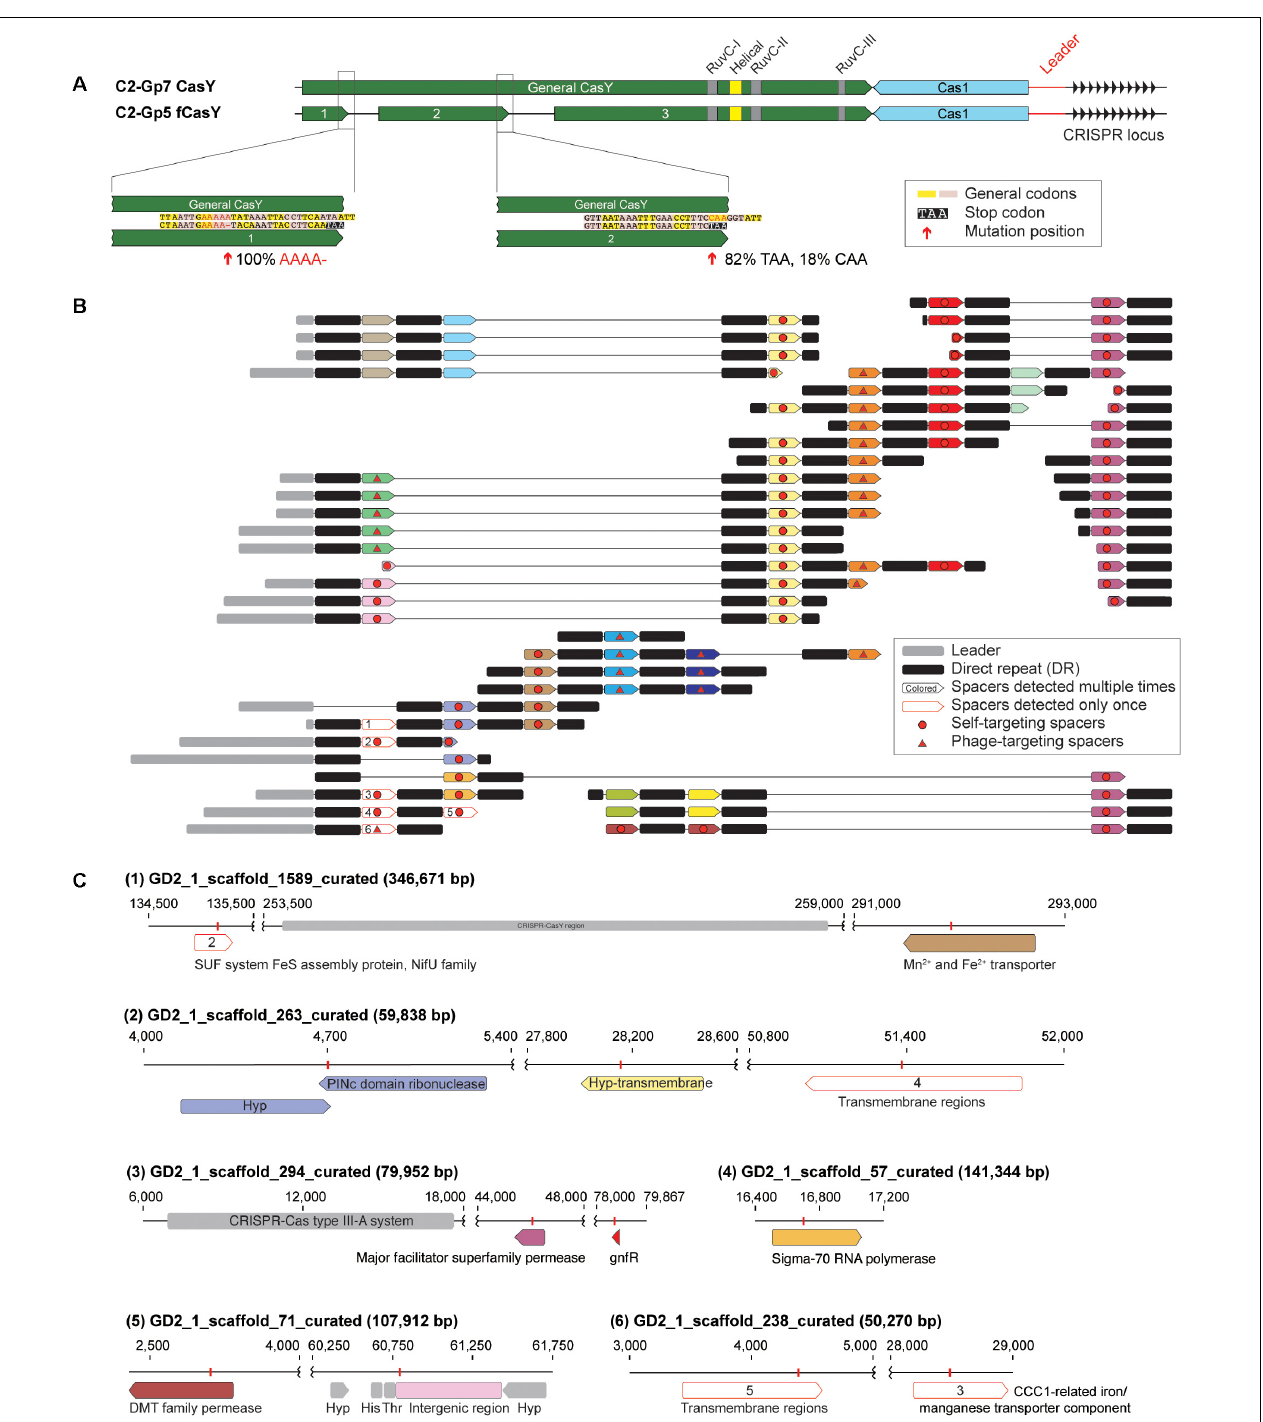
FIGURE 5 | One Roizmanbacteria genome encodes and unusual CRISPR system with a fragmented CasY (fCasY) protein and self-targeting spacers. (A) Mutations leading to fragmentation of CasY proteins into three pieces (red arrows) and their incidence in the population, and other features of the locus. (B) The reconstructed CRISPR locus showing the history of spacer acquisition and the distribution of self-targeted spacers (marked by red circles). (C) Scaffolds encoding genes and an intergenic region matching the self-targeting spacers. The targeted genes have the same color as the corresponding spacers in (B) , genes targeted by single copy spacers [white in (B) ] are indicated by numbers, and CRISPR-Cas systems, tRNA and other genes on the scaffolds are shown in gray.